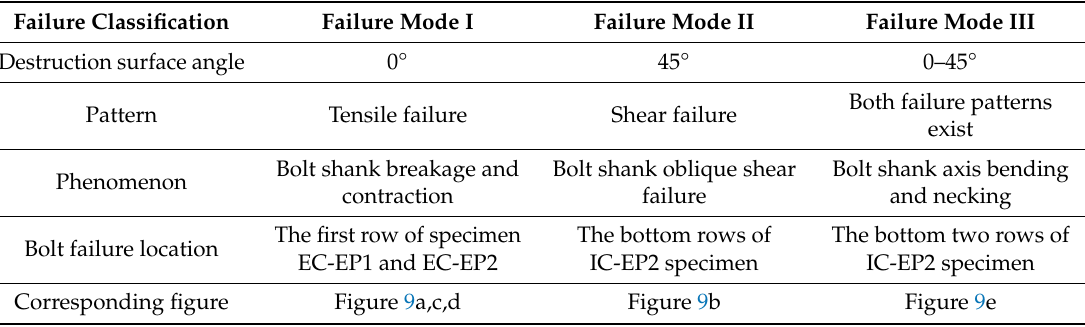
Table 4. Typical failure modes of the